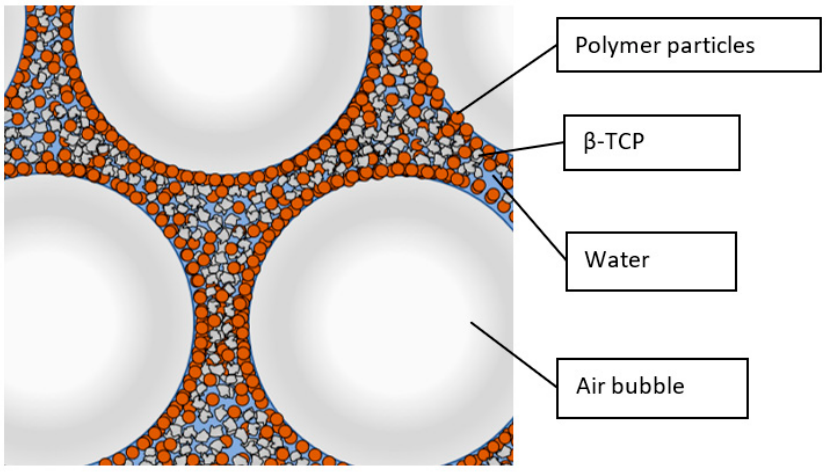
Figure 14. Arrangement of polymer and ceramic particles during solid stabilization.